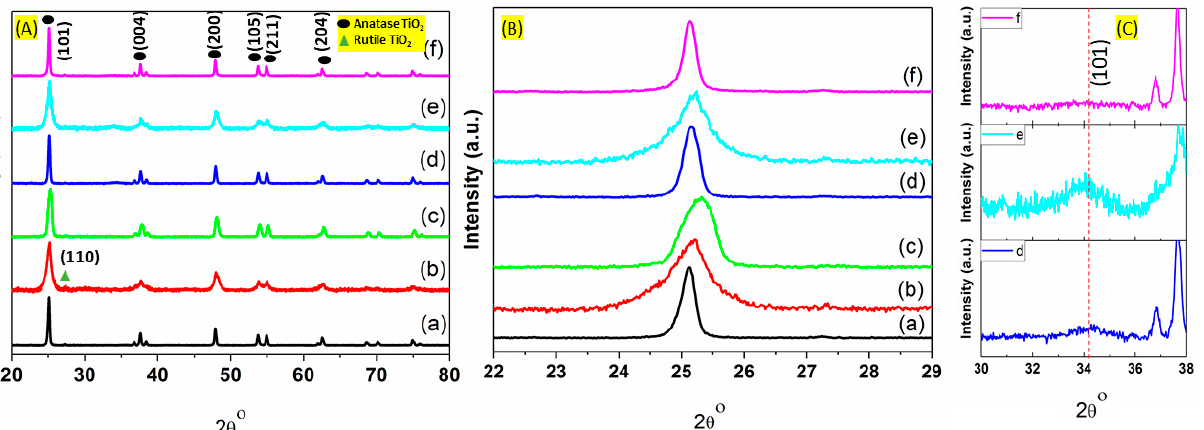
Figure 2. ( A ) XRD patterns of (a) Cu-TNS, (b) Cu-TNT, (c) Cu-TNW, (d) Pd-Cu-TNS, (e) Pd-Cu/TNT, (f) Pd-Cu/TNW catalysts. ( B ) TiO 2 anatase (101) reflection of the catalysts in ( A ); ( C ) PdO (101) reflection for the (d–f) catalysts of ( A ).